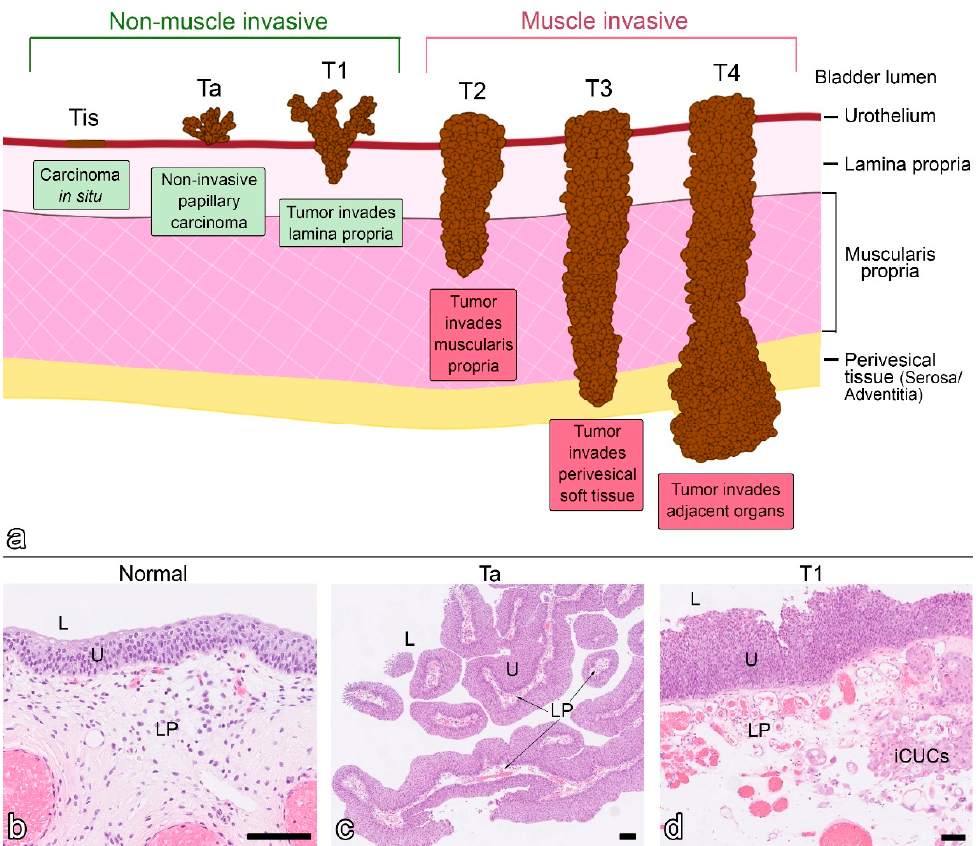
Figure 2. Staging of bladder cancer (BC) according to the Tumour, Node, Metastasis classification system ( a ). Tumours that are confined to the mucosa, including carcinoma in situ (Tis) and papillary tumours (Ta), or that have not invaded beyond the lamina propria (T1) are grouped under the term non-muscle invasive BC, whereas those that infiltrate the muscularis propria and beyond (T2–T4) are grouped under the term muscle invasive BC. Representative histological sections of human normal bladder mucosa ( b ), non-muscle invasive papillary BC (Ta) ( c ) and papillary BC infiltrating the lamina propria (T1) ( d ). iCUCs, invading cancer urothelial cells; L, lumen of bladder; LP, lamina propria; U, urothelium. Scale bar, 100 µ m ( b – d